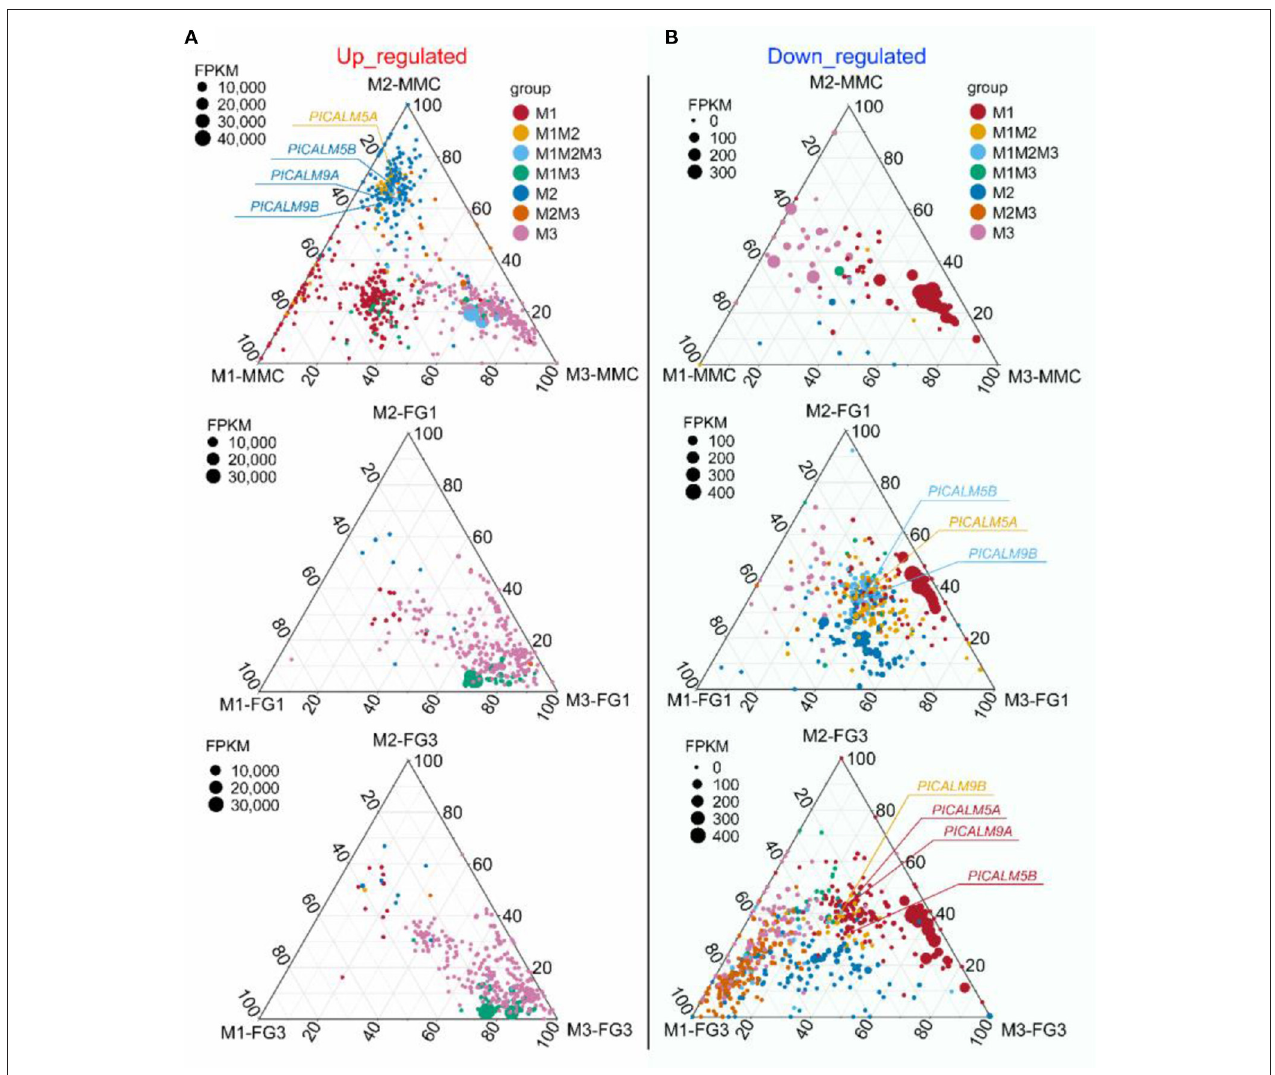
FIGURE 5 | A ternary plot of all DEGs from ap1g2-1 + / − (M1), ap1g2-1/ap1g2-3 (M2), and ap1g2-3 − / − (M3) at MMC, FG1, and FG3 stages. (A) The upregulated DEGs of the three ap1g2 mutants at each stage; (B) The downregulated DEGs of the three ap1g2 mutants at each stage. Each circle represented one DEG. The size of each circle represented one DEG’s FPKM. The position of each circle was determined by the contribution of the indicated compartments to the total FPKM. The dotted grid and numbers inside the plot indicated 20% increments of contribution from each gene. Red circles denoted the specific DEGs of ap1g2-1 + / − . Yellow circles denoted the overlapping DEGs of ap1g2-1 + / − and ap1g2-1 + / − /ap1g2-3 + / − . Light blue circles denoted the overlapping DEGs of ap1g2-1 + / − and ap1g2-1 + / − /ap1g2-3 + / − and ap1g2-3 − / − . Green circles represented the overlapping DEGs of ap1g2-1 + / − and ap1g2-3 − / − . Dark blue circles represented the specific DEGs of ap1g2-1 + / − /ap1g2-3 + / − . Orange circles represented the overlapping DEGs of ap1g2-1 + / − /ap1g2-3 + / − and ap1g2-3 − / − , and pink circles represented the specific DEGs of ap1g2-3 − / −